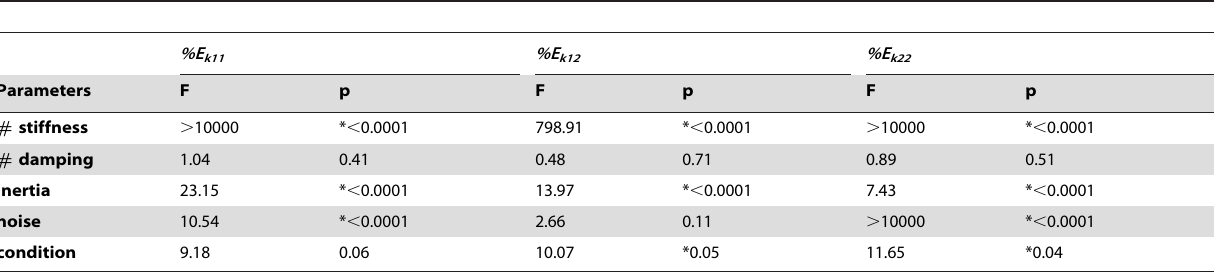
Table 9. Repeated measures ANOVA for the percentage RMS error using displacement steady state regression among different inertial methods with stiffness and damping time-profiles as random factors along the interval 2.5–5 s.